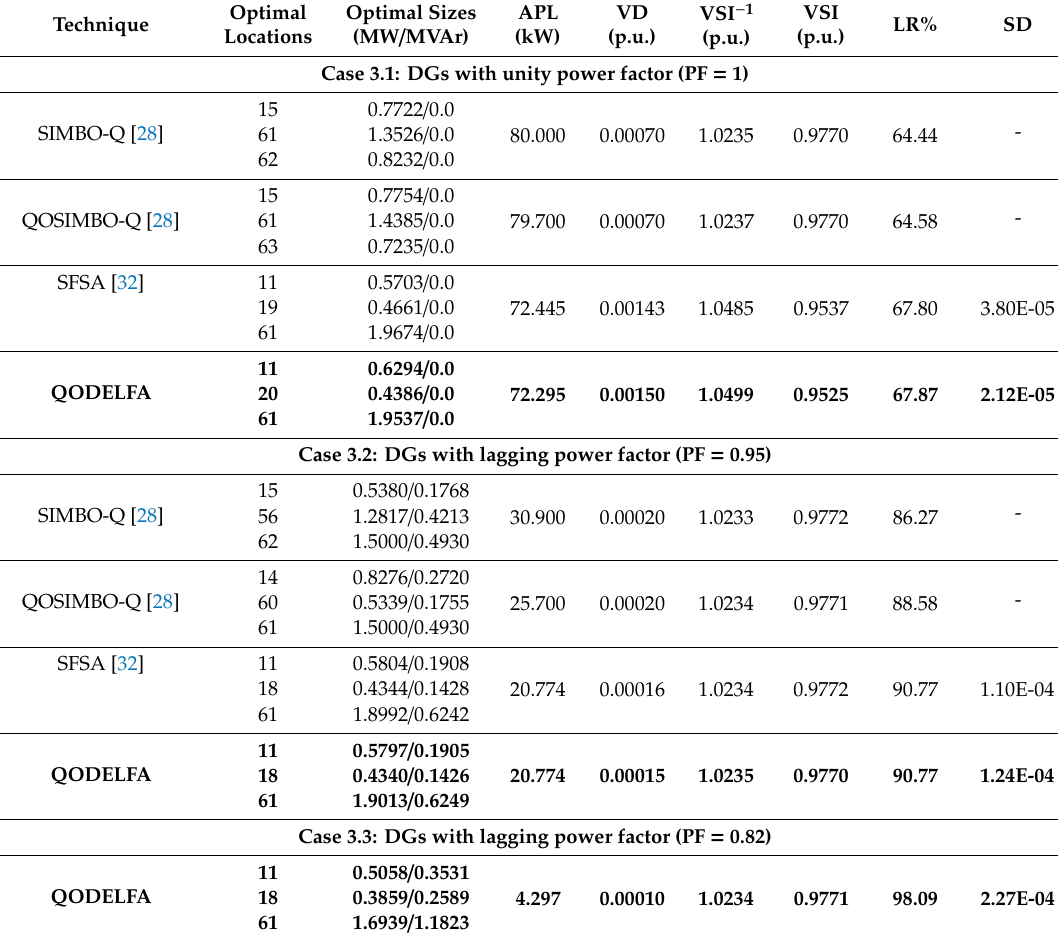
Table 8. Results for the IEEE 69-bus RDS with simultaneous minimization of OF 1 , OF 2 and OF 3